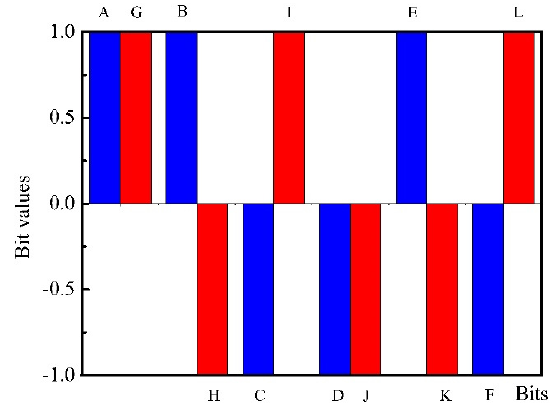
Figure 6. Binary and ternary fingerprints of the bacterium sample. Red: measurement-1; blue: measurement-2 (of the same sample).